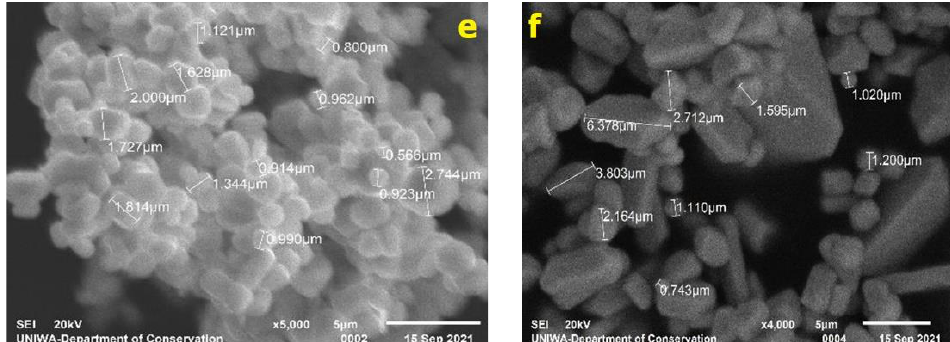
Figure 3. SEM fragments from the: ( a ) Gd 2 O 2 S:Tb UKL65/UF-R1, ( b ) Gd 2 O 2 S:Tb UKL65/F-R1, ( c ) Gd 2 O 2 S:Eu UKL63/UF-R1, ( d ) Gd 2 O 2 S:Eu UKL63/N-R1, ( e ) Gd 2 O 2 S:Pr,Ce,F UKL59CF/F-R1, and ( f ) Gd 2 O 2 S:Pr,Ce,F UKL59CF/S-R1 phosphors.